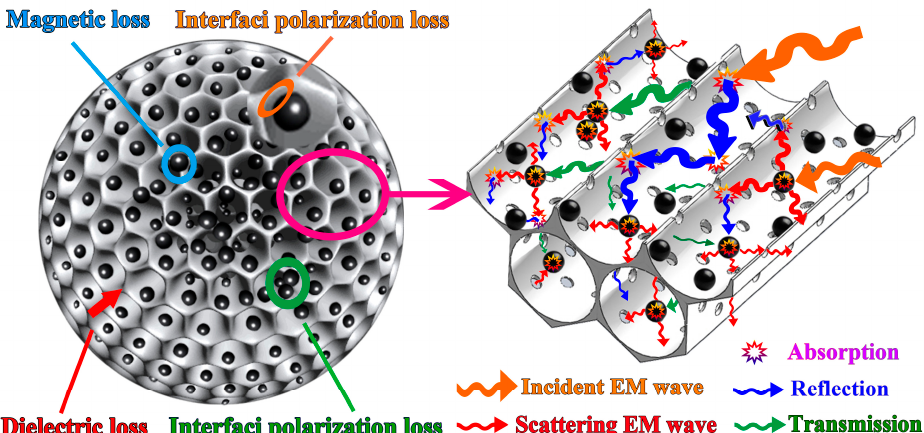
Figure 11. The schematic diagram of the possible microwave loss mechanism for the 3D-GLM/Fe 3 O 4 .